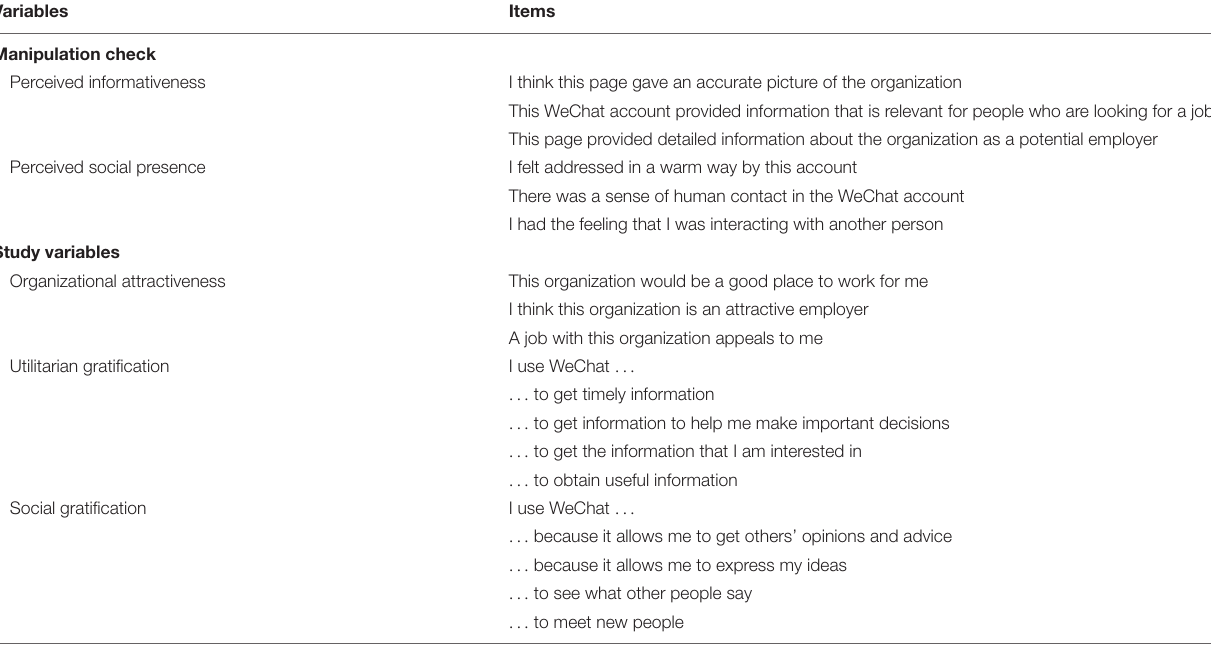
TABLE 1 | Measures and Items of the Manipulation Check and Study Variables. Variables Items